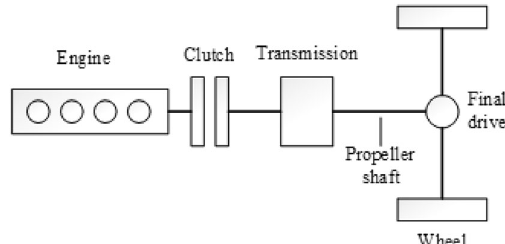
Figure 1 Structural diagram of driveline